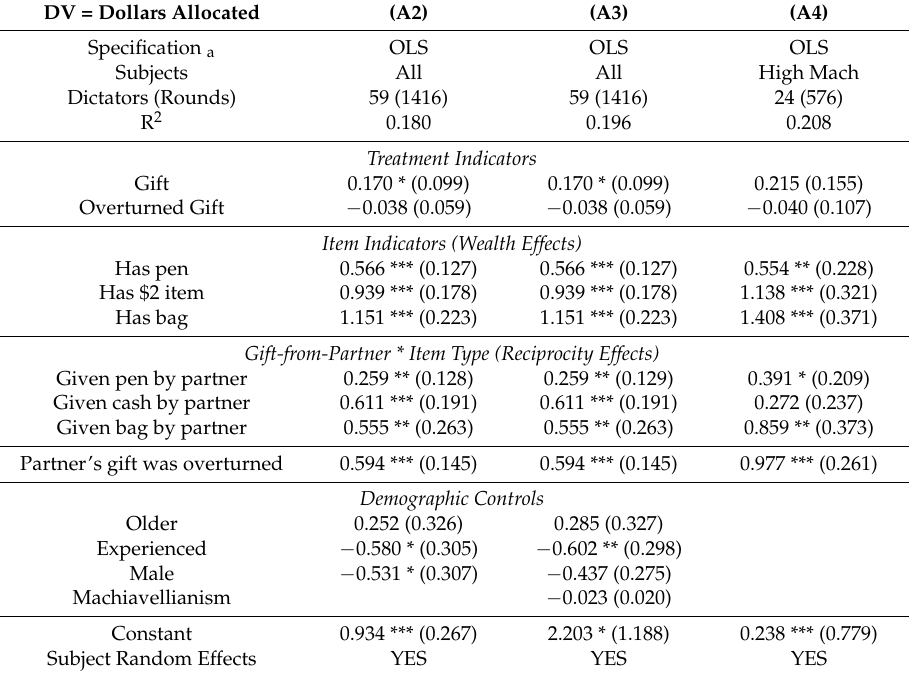
Table A3. Main Results with Demographic Controls (Includes Caltech